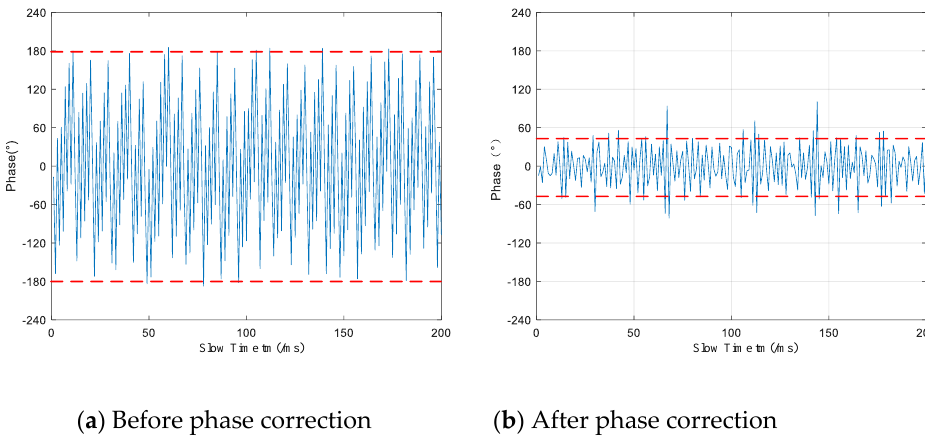
Figure 10. Signal phase diagrams before and after correction. The phase-corrected signals are coherently accumulated to obtain a two-dimensional map in the “ time-distance domain ” , as shown in Figure 11. Compared with Figure 9, the SNR of the signal has been greatly improved.